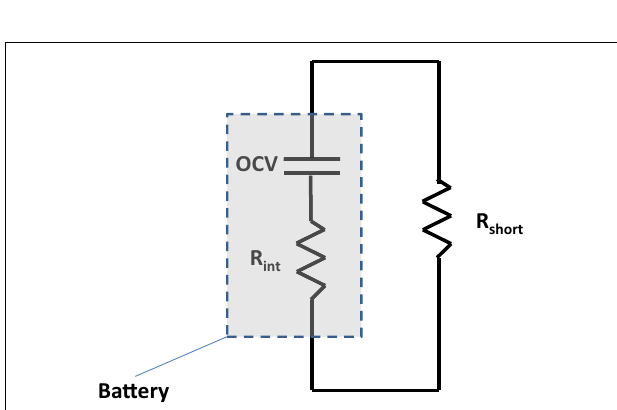
FIGURE 3 | Generalized triad of factors that dictate large-format Li-ion battery safety .